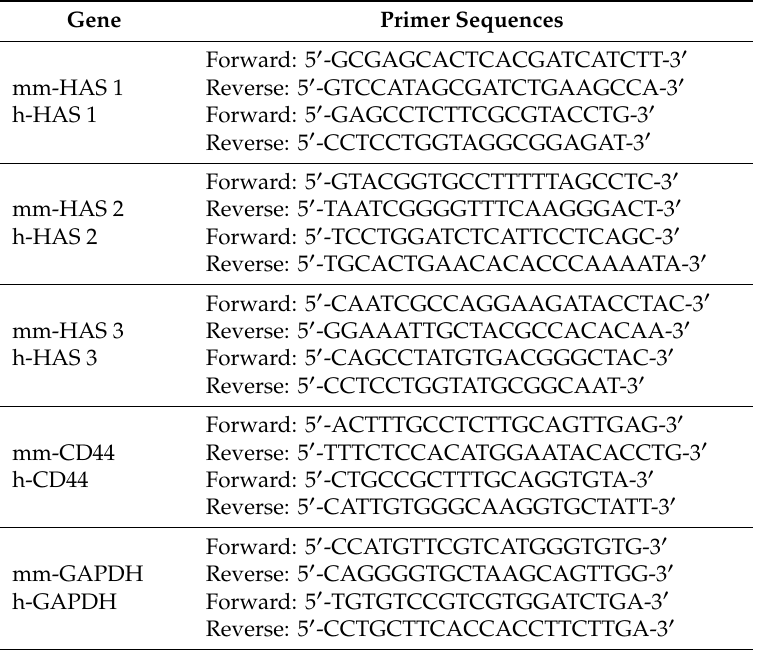
Table 1. List of the primer sequence used in the